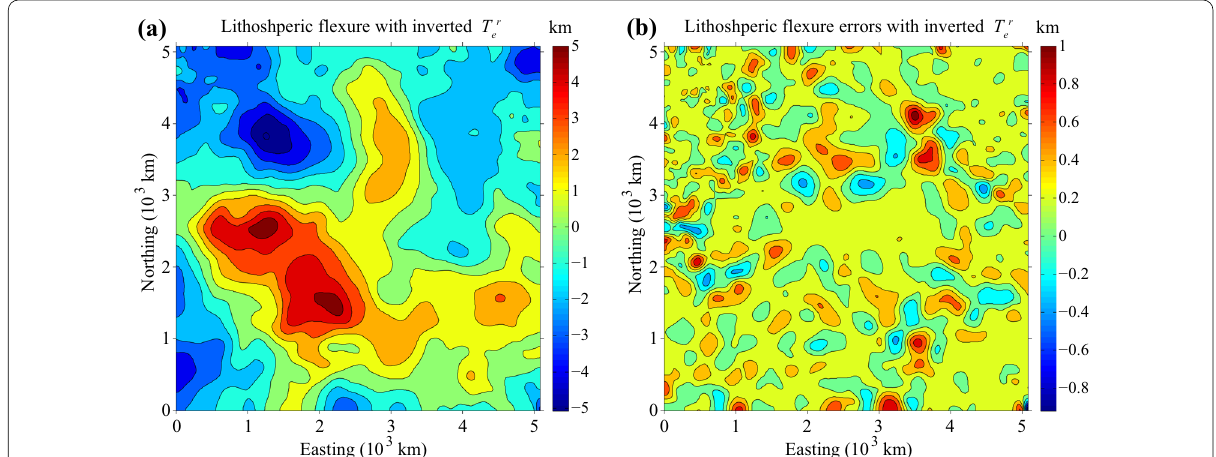
Fig. 9 a Lithospheric flexure using the inverted T e r grid. b Lithospheric flexure errors for the model inversion using the inverted T e r grid